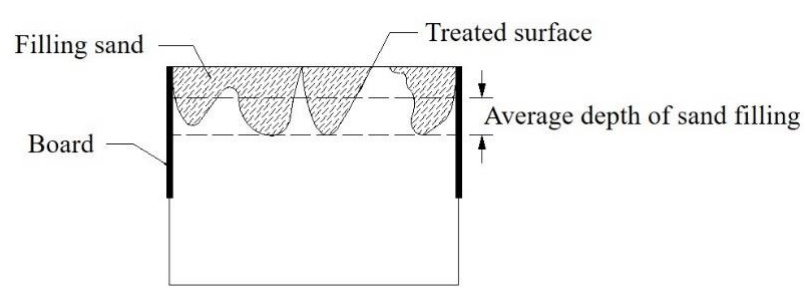
Figure 5. Schematic diagram of the sand filling method.